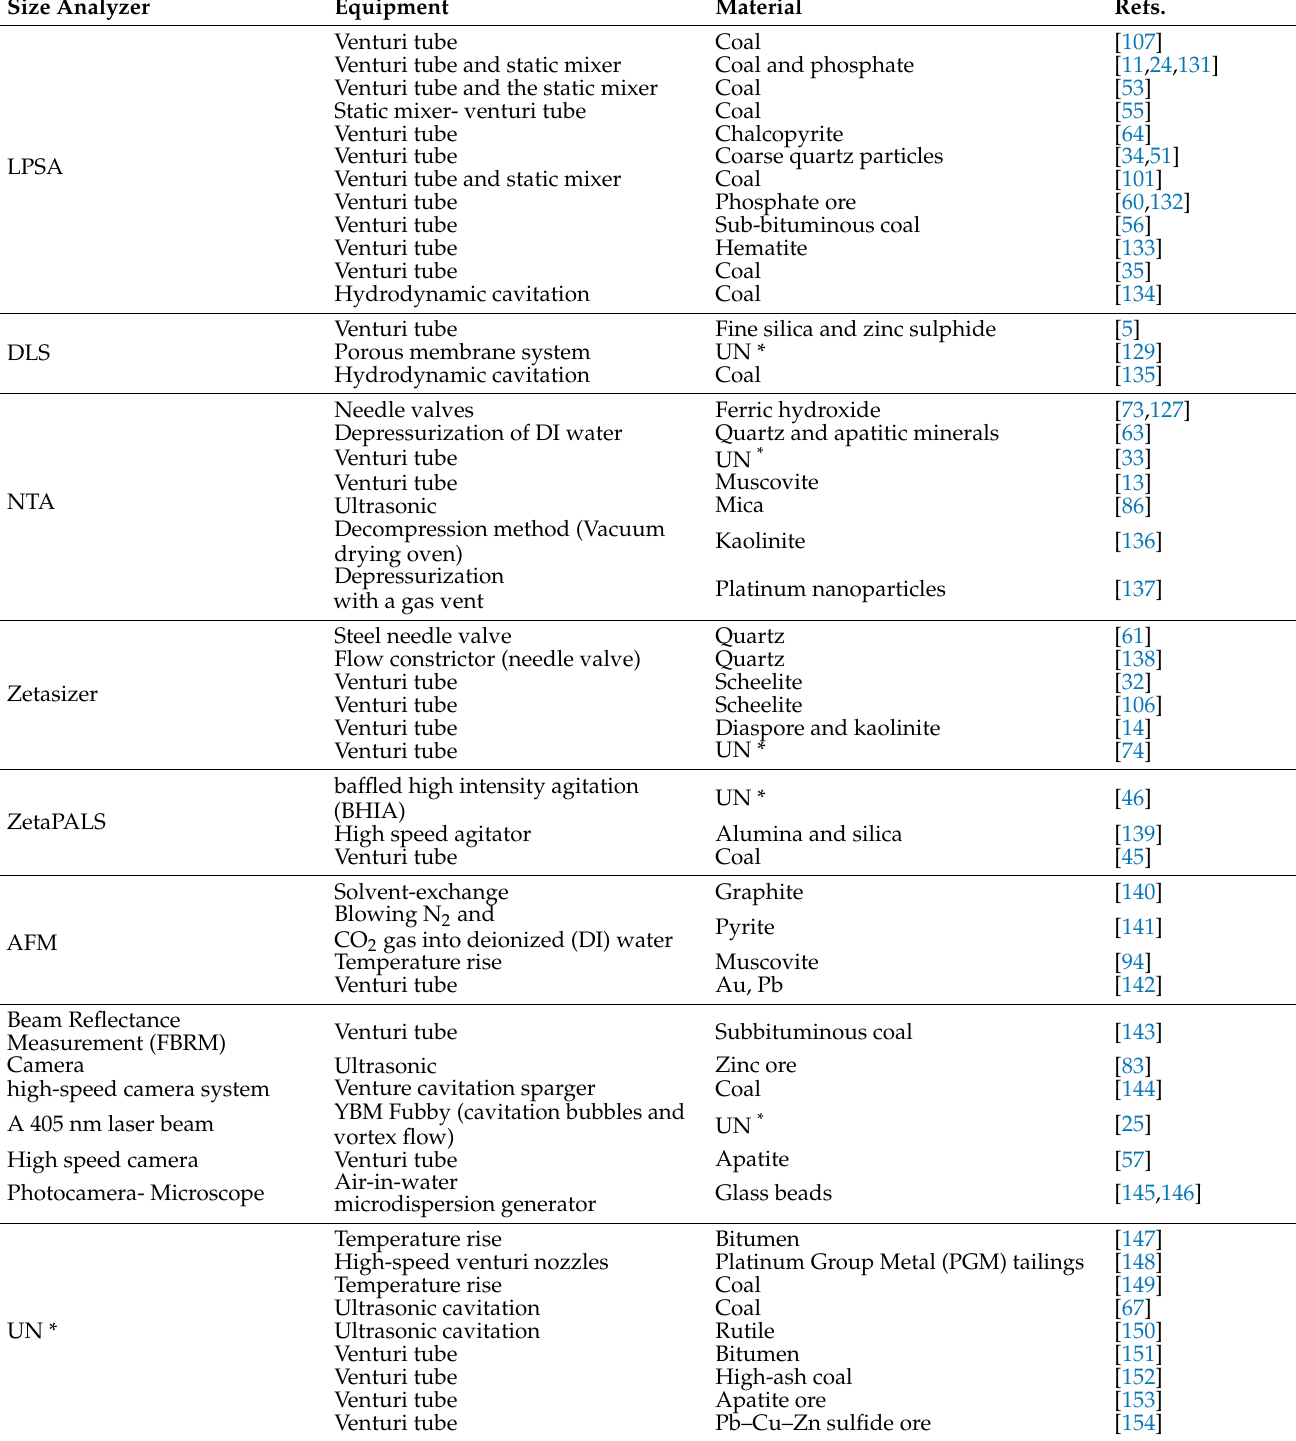
Table 2. Comparison of three major techniques to measure the size of